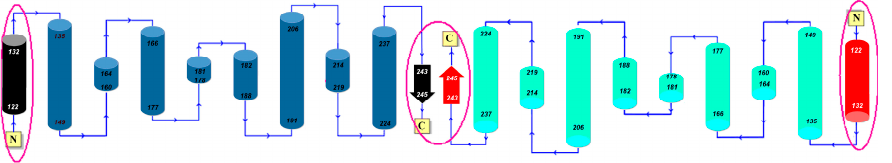
Figure 10. FOD domain structure distinguished by red ellipses. The color patter is identical to the one used in Figure 8.